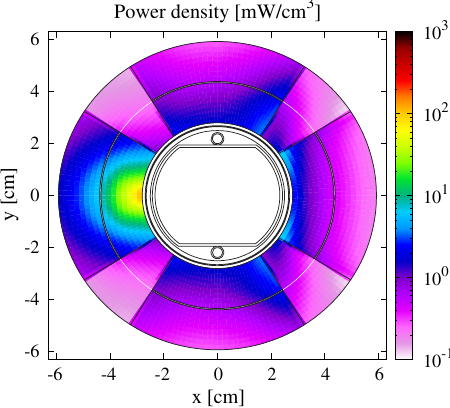
FIG. 23. Simulated transverse power density distribution dur- ing the static orbit-bump quench test in MQ.12L6 coils at the location where the maximum energy deposition occurs. Results correspond to 3 × 10 8 protons impacting on the magnet beam